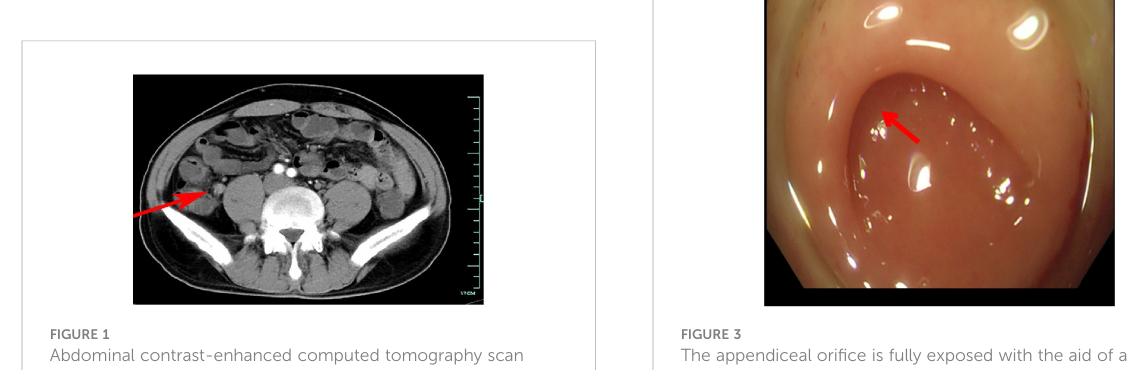
FIGURE 3 The appendiceal ori fi ce is fully exposed with the aid of a transparent